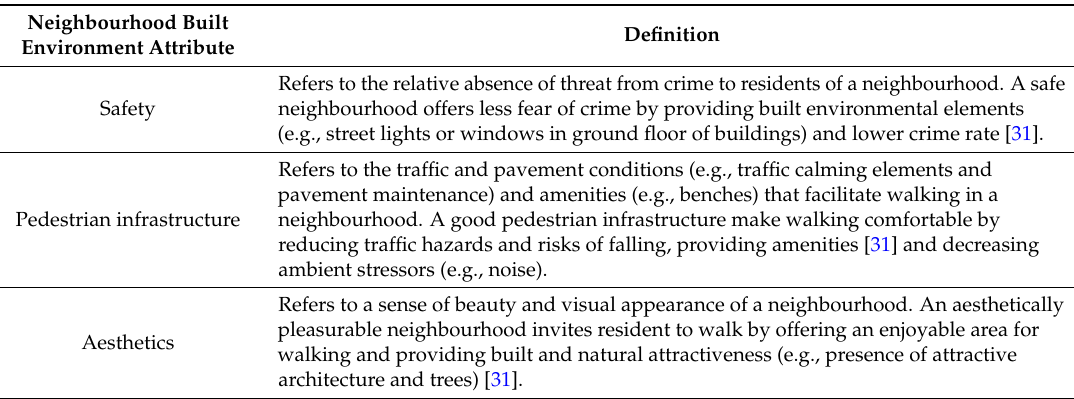
Table 1. Definitions of neighbourhood safety, pedestrian infrastructure and